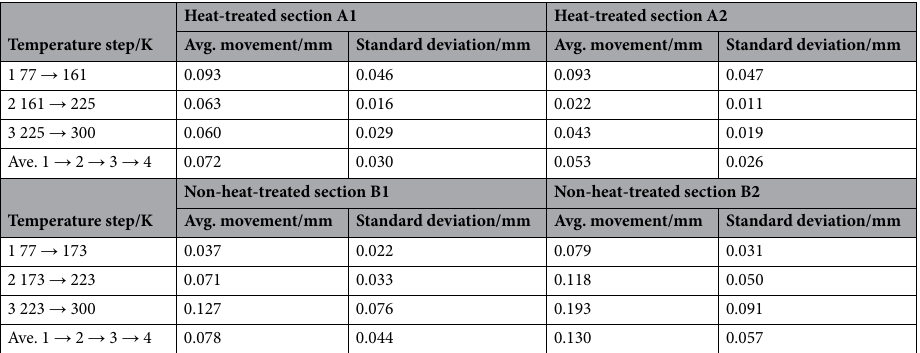
Table 1. Average strand movement as a function of temperature. (Top) The measured values determined through DIC for the heat-treated sections A1 and A2, with associated standard deviations. (Bottom) The corresponding values for the temperature ranges measured at each step of the non-heat-treated sections B1 and B2. The steps are comparisons of the relative movement of the conductor strands within the temperature intervals shown. The final line is the overall average movement between